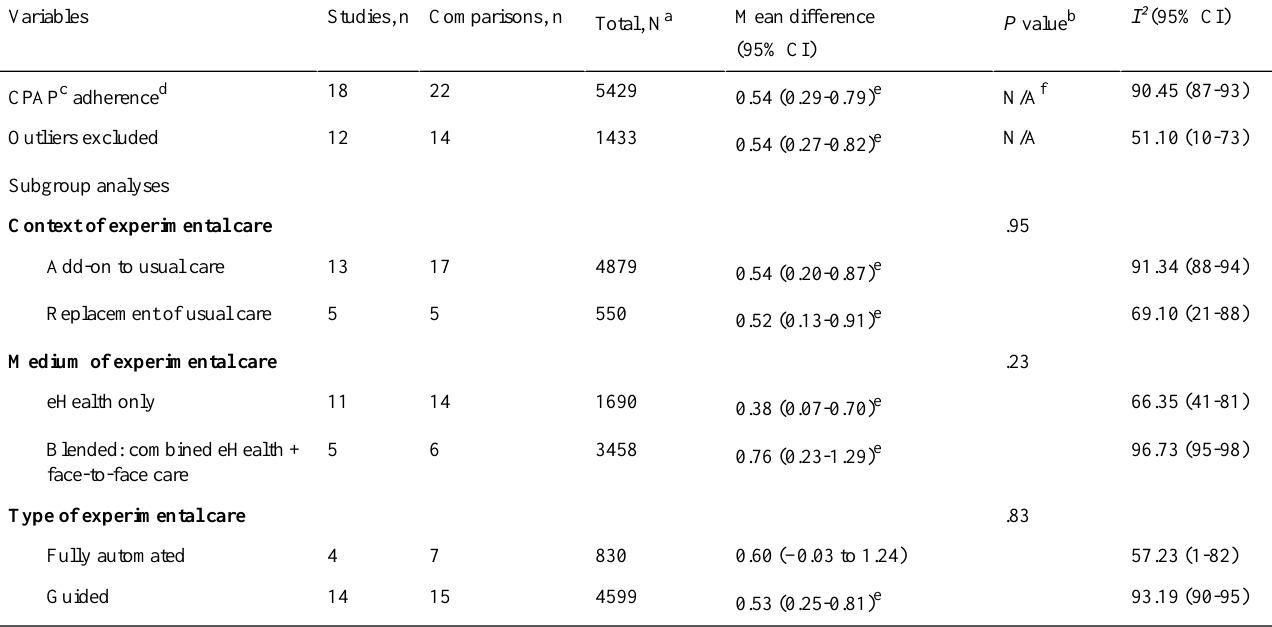
Table 1. Results of the main and subgroup analyses at postintervention assessment.